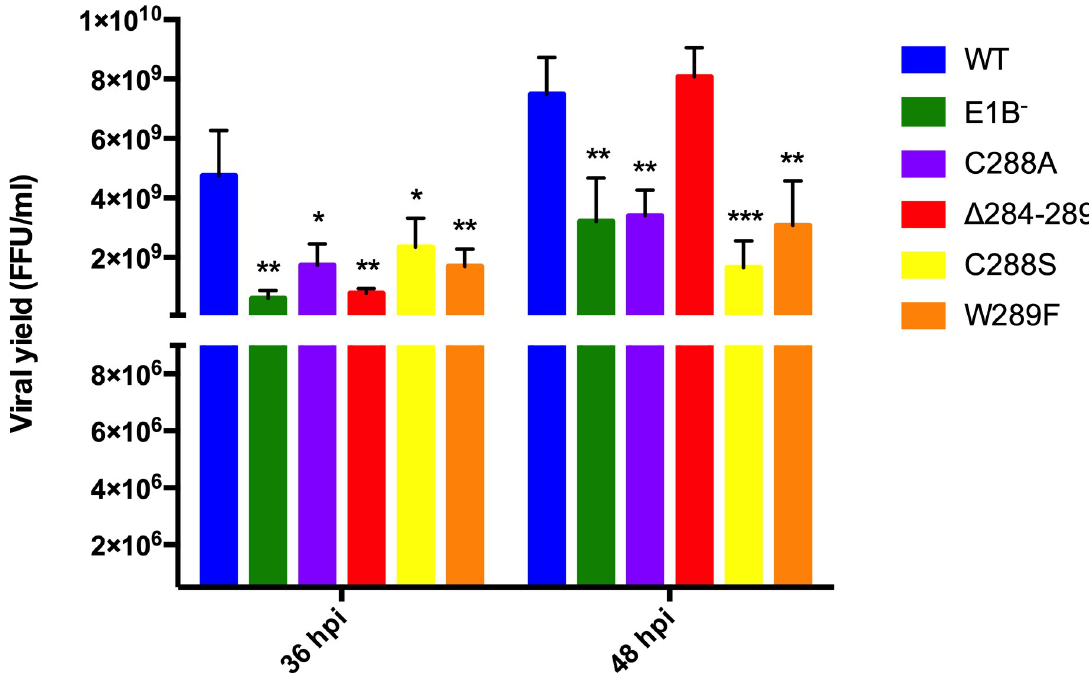
Fig 3. Effect of substitutions in the E1B 55K RNP motif on viral progeny production. HFF cells were infected at a MOI 30 FFU/cell and harvested at 36 and 48 hpi. Viral titers were determined in 293 cells by fluorescent foci using a mouse monoclonal anti-E2 72K (DBP) antibody. The standard deviations from two independent titration experiments are shown. � P < 0.05, �� P < P0.01, ��� P < 0.001.